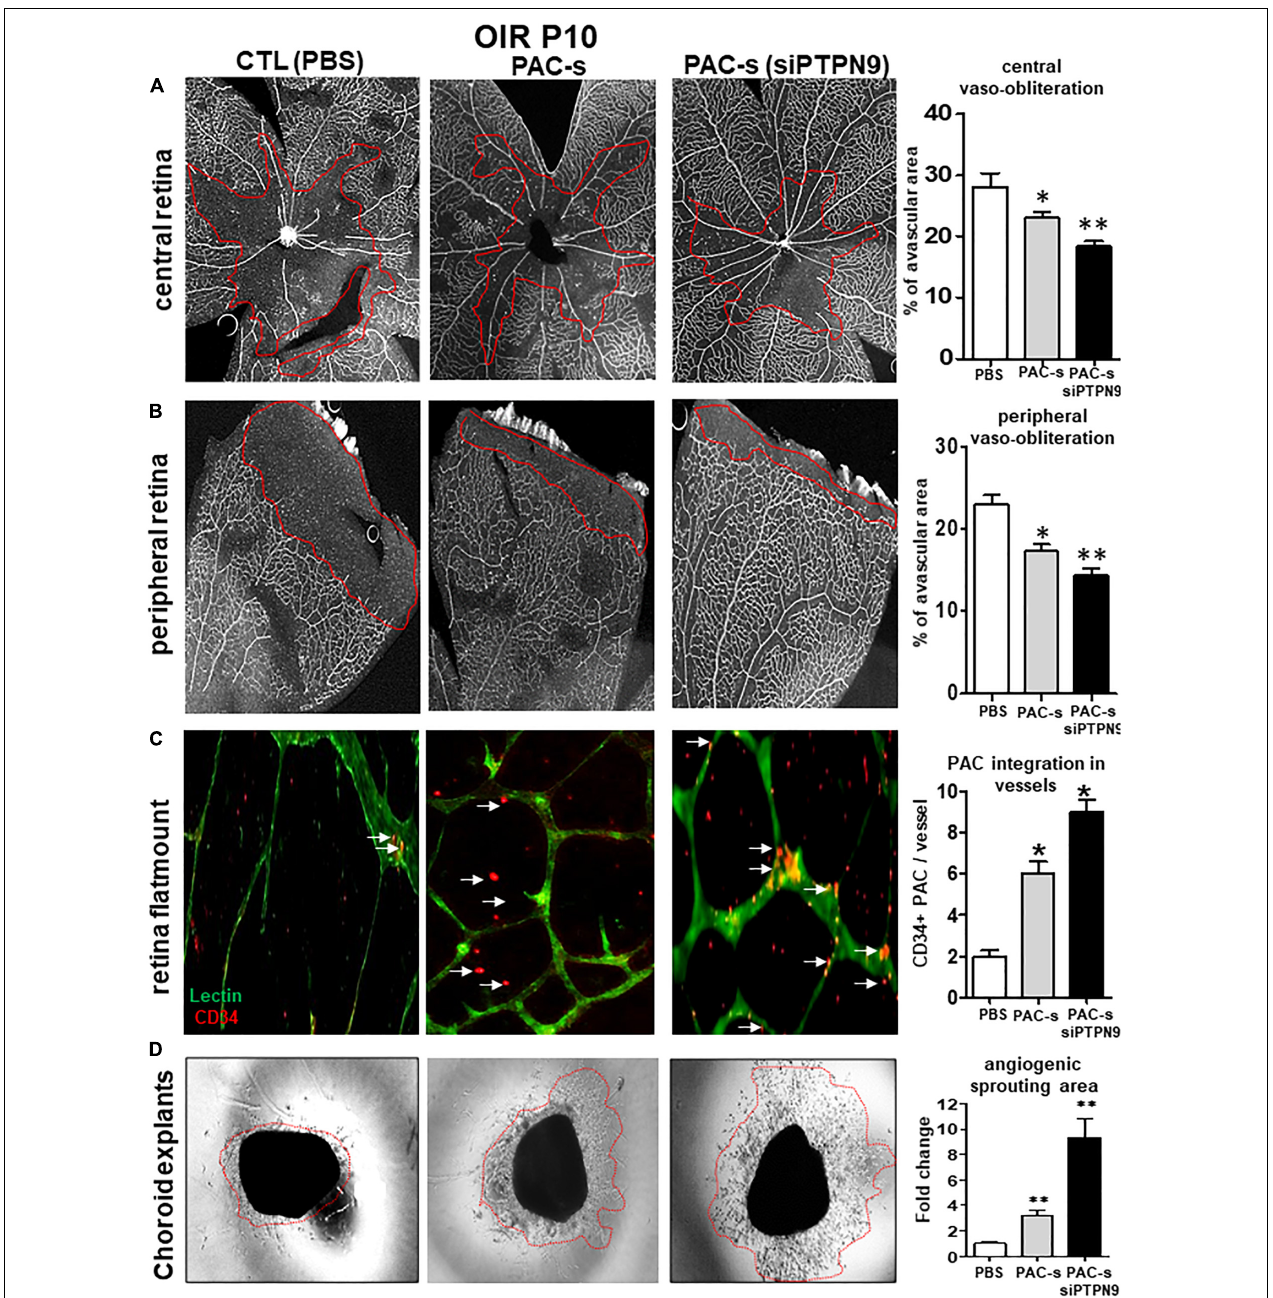
FIGURE 5 | Intraocular injection of siPTPN9-PAC-s improves PAC recruitment and attenuates retinal vaso-oblioteration in rat OIR. (A) OIR-subjected rats were treated with a single intravitreal injection (1 µ l of 50 × concentrate) of PAC-s or siPTPN9-PAC-s or PBS at P5, before exposure to hyperoxia. Animals were then exposed to constant hyperoxia (80% O 2 ) until P10. (A,B) Representative flat mount images and quantitative analysis of central (A) and peripheral (B) retinal vaso-obliteration in OIR-subjected rats treated or not with PAC-s or siPTPN9-PAC-s. (C) Representative images and analyses of PACs (CD34 + , orange) co-localizing into vessels (isolectin positive, green)of OIR-subjected rats treated or not with PAC-s or siPTPN9- PAC-s. (D) Representative images of choroid explant vascular sprouting (Matrigel) in tissues from OIR animals treated or not with PAC-s or siPTPN9- PAC-s. Data are mean ± SEM. * P < 0.05 or ** P < 0.01 vs. PBS (control). N =